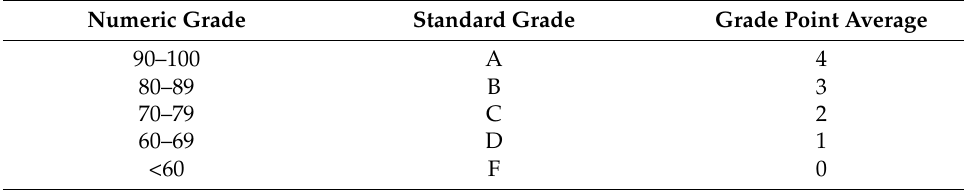
Table 1. Number grade